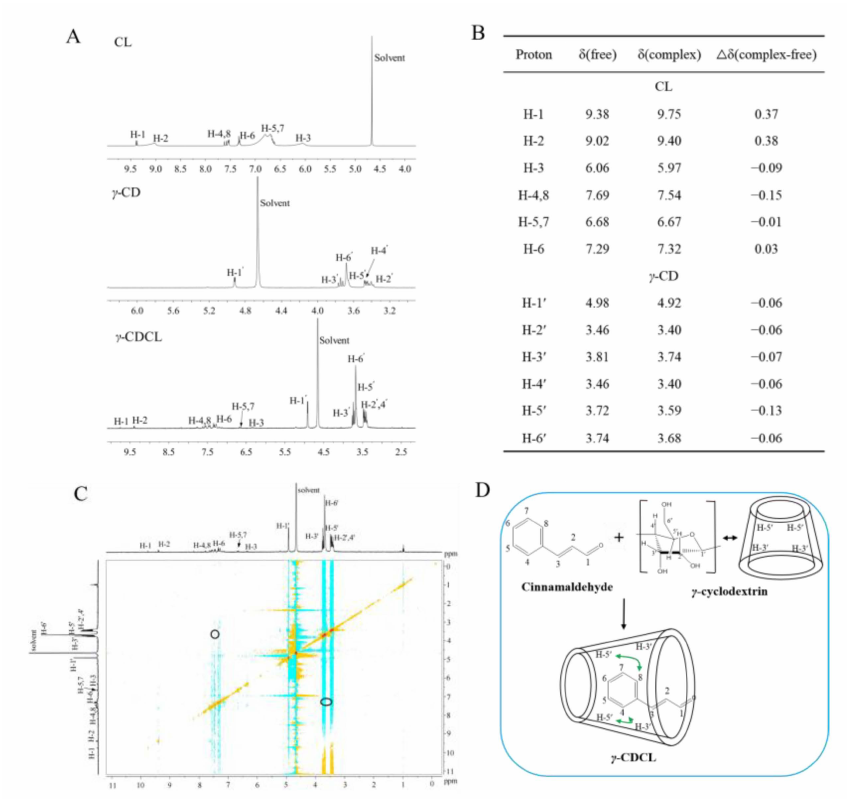
Figure 4. 1 H NMR spectra of CL, γ -CD, and γ -CDCL in D 2 O ( A ); Chemical shifts of protons of CL and γ -CD in γ -CDCL ( B ); The 2D ROESY of the γ -CDIC in D 2 O ( C ); The encapsulation mode of the γ -CDCL ( D ). 1 H NMR, 1 H nuclear magnetic resonance; 2D ROESY, two-dimensional rotating frame nuclear Overhauser spectroscopy; CL, cinnamaldehyde; γ -CD, γ -cyclodextrin; γ -CDCL, cinnamaldehyde/ γ -cyclodextrin inclusion